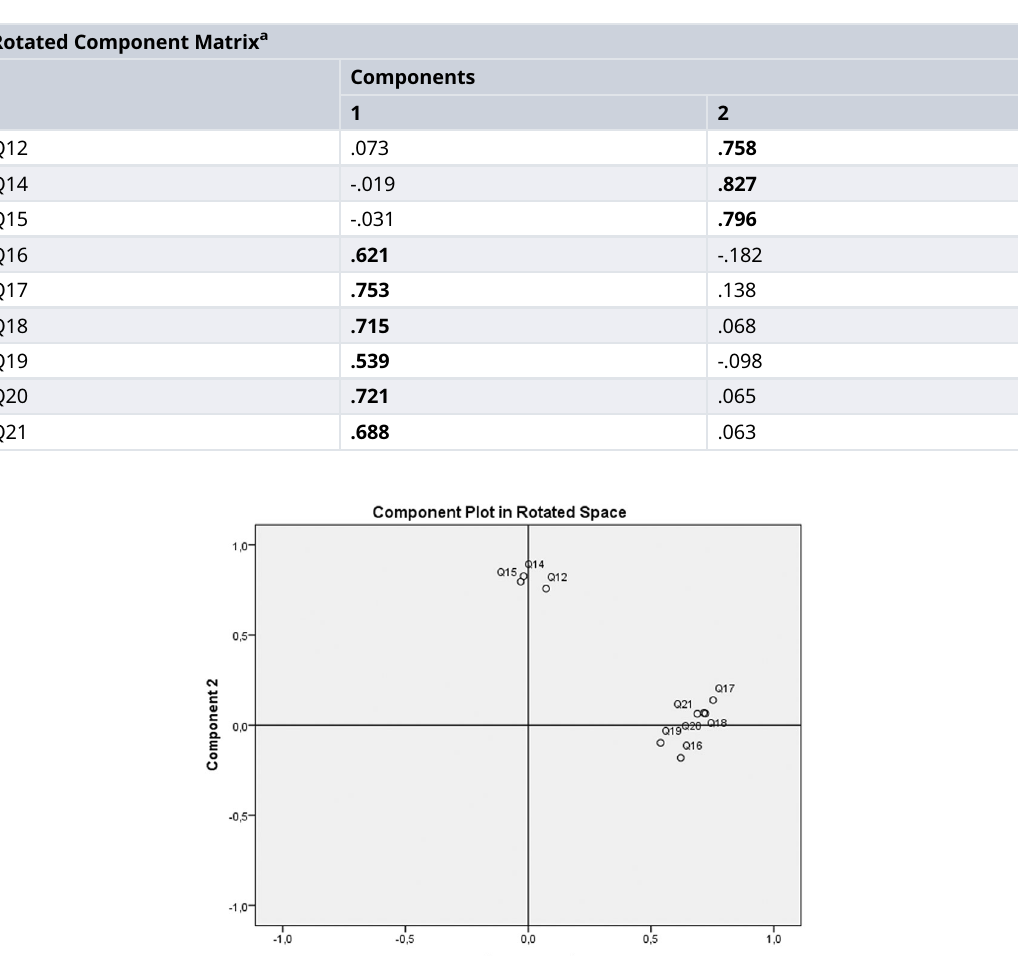
Table 1. Principal Component Analysis (PCA): correlation between questions and components (factors) after Varimax rotation. The functional vaccine literacy questions (Q12, Q14, Q15) and the interactive/critical COVID-19 vaccinationliteracyquestionscontaintwocomponents(Factor1andFactor2);thevalueinboldcorrespondstoeach variable with the factor with the greatest